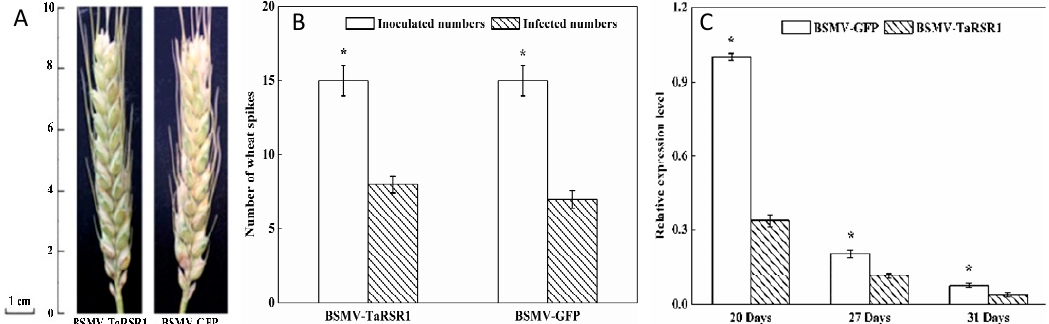
Figure 1. Phenotypes ( A ); number ( B ); and TaRSR1 gene transcription levels ( C ) of the BSMV-TaRSR1-infected and BSMV-GFP-infected wheat spikes. Appearance of chlorosis on the inoculated wheat spikes at 22 days after anthesis suggests that BSMV virus has been infected and the target genes are successfully silenced by VIGS in this tissue. Efficiency of the BSMV-VIGS method was based on chlorosis phenotype, and the average values of the number of VIGS infection from 15 plants were considered as one replicate and three independent biological replicates were performed. Transcription levels at 20, 27 and 31 days after anthesis were measured by qPCR using Actin gene as internal control. Each value is the mean ± standard deviation of three independent biological replicates. Asterisks indicate significant differences ( p < 0.05).